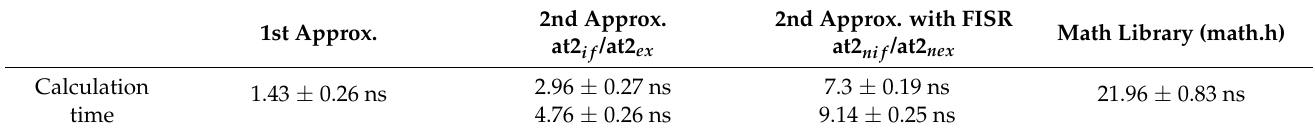
Table 2. Calculation time evaluation of 2nd approximations of atan2 (Average ± S.D.)